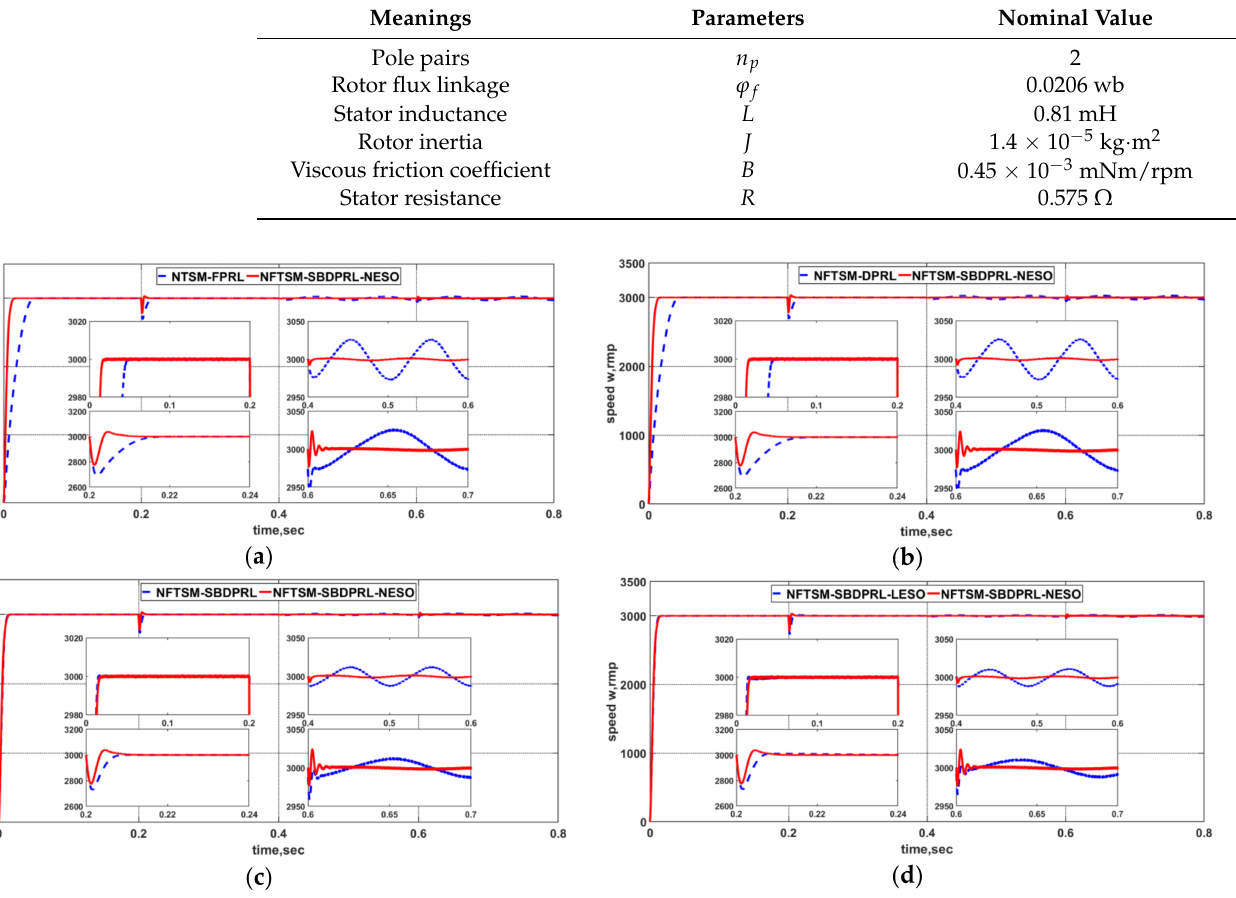
Figure 2. Response curves of the PMSM under NFTSM-SBDPRL-NESO and the other four control methods for comparison: ( a ) NTSM-FPRL and NFTSM-SBDPRL-NESO, ( b ) NFTSM-DPRL and